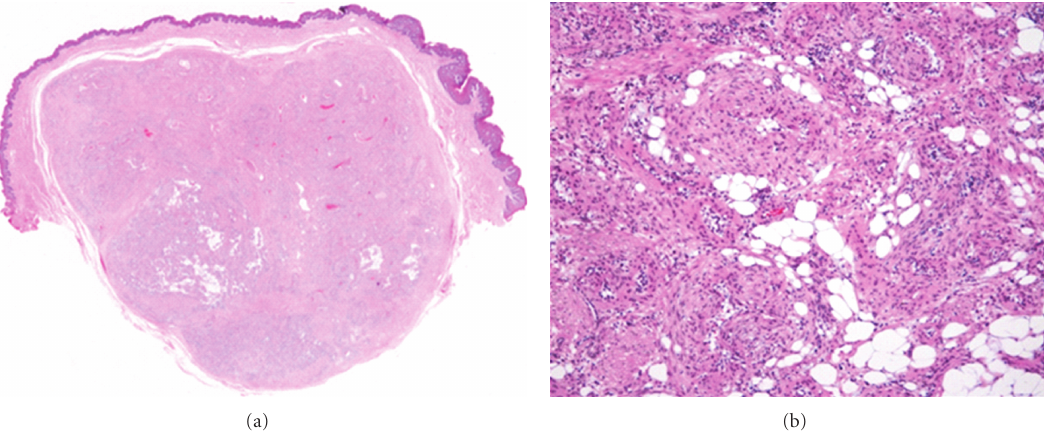
Figure 3: Photomicrograph of an angiomyolipoma of the tongue. (a) An encapsulated lesion composed of a proliferation of an intricate mixture of mature adipose tissue, blood vessels, and smooth muscle (H-E staining, magnification × 10). (b) Many large blood vessels with thick muscular walls (H-E staining, magnification ×